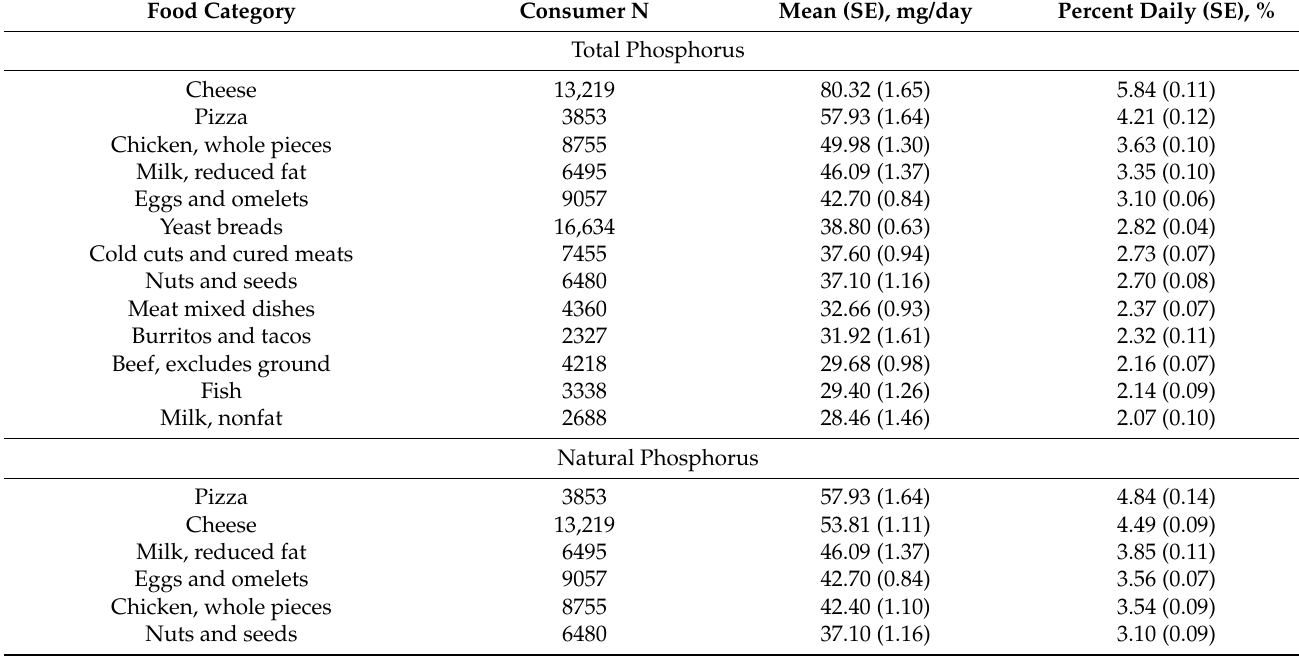
Table 3. Top dietary sources 1 of total, natural, and added phosphorus intake (mg/day) and percentage of total